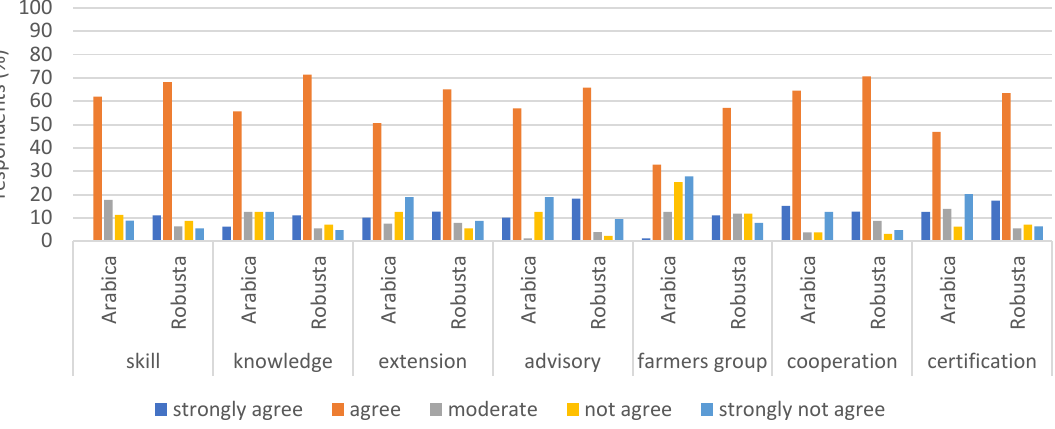
Figure 4. Distribution farmers’ assessment of process barriers.